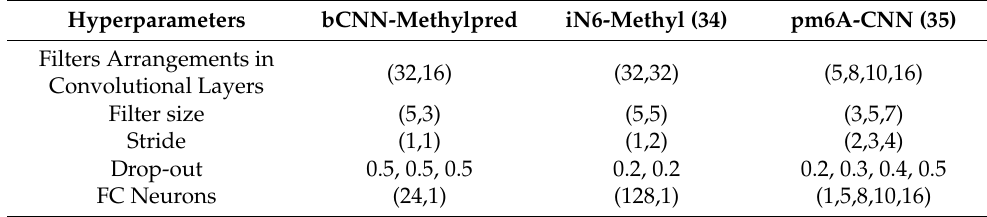
Table 13. Parameter comparison of proposed approach with competitor